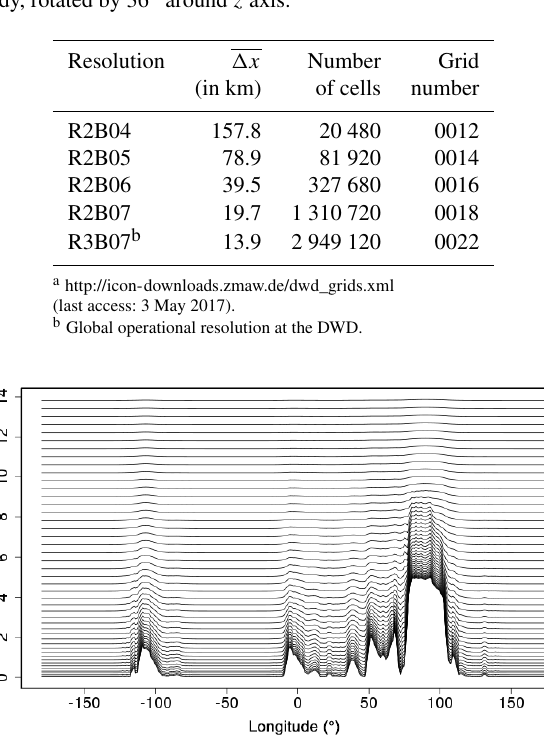
Table 1. Examples of ICON resolutions with characteristic length (cid:49)x and total number of cells (from Zängl et al., 2015). Char- acteristic length and number of cells are calculated according to √ (cid:49)x = π/ 5 R/(n 2 k ) and n c = 20 n 2 4 k ( R = Earth’s radius and n and k as ICON resolution indicators). The grid number denotes the official ICON grid number a for the grid configuration used in this study, rotated by 36 ◦ around z axis.